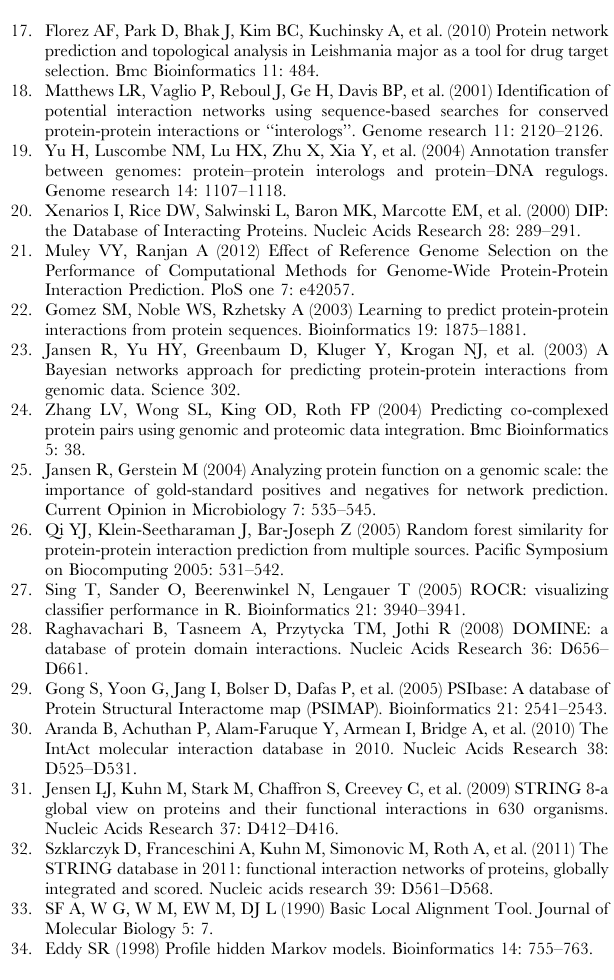
Table S1 Leishmania braziliensis PPI network. Descrip- tion of all predicted protein interactions and their confidence scores for L. braziliensis predicted proteome. Table S2 Leishmania major PPI network. Description of all predicted protein interactions and their confidence scores for L. major predicted proteome. Table S3 Leishmania infantum PPI network. Description of all predicted protein interactions and their confidence scores for L. infantum predicted proteome. Table S4 Annotation of Functional Modules (Clusters) predicted for the three PPI networks. Description of predicted modules including their scores, p-values and GO term id. Table S5 Topological analysis. Values of MCC and Degree indexes calculated for the proteins present in the three PPI networks modeled. Table S6 Analysis of top 20 ranked proteins of each PPI network. Detailed description of top 20 ranked proteins by MCC